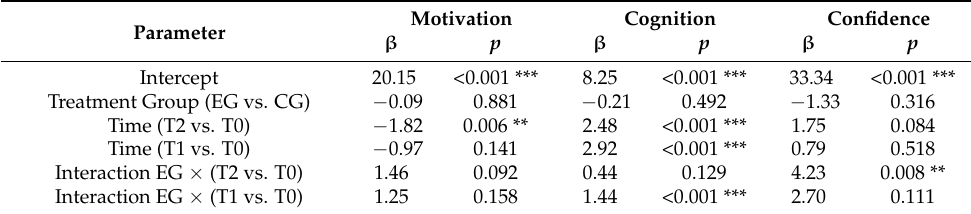
Table 4. GEE analysis of intervention effect on motivation, cognition, and